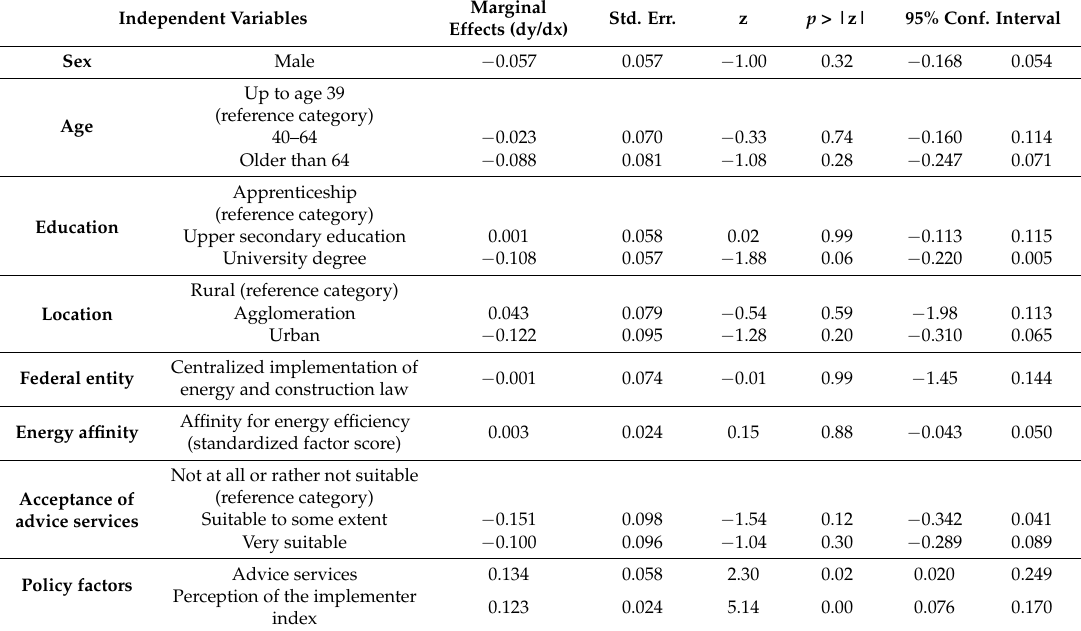
Table A1. Marginal effects on the effectiveness of subsidies beyond free riding. Independent Variables